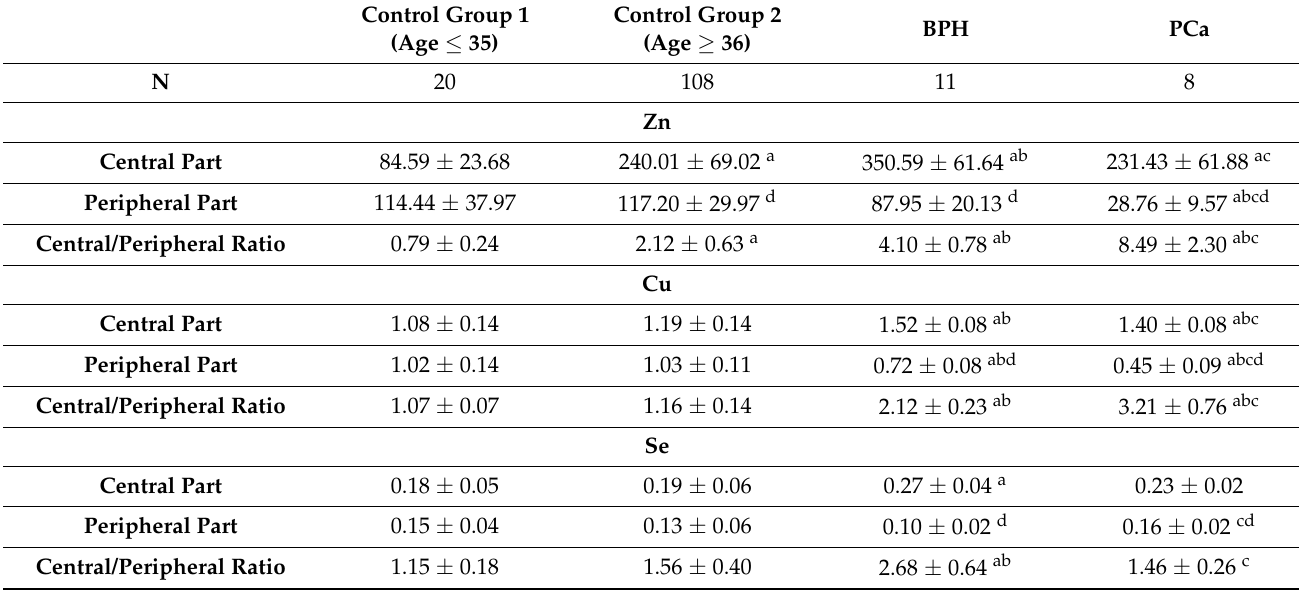
Table 2. Zinc, copper and selenium concentrations ( µ g/g wet tissue) in the central and peripheral parts of the prostate in age groups with no proliferative changes and in the groups with BPH and PCa. All values are expressed as means ± SD.